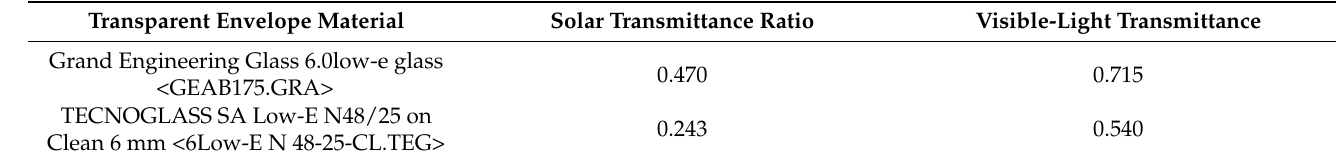
Table 3. Thermal performance parameters of the transparent